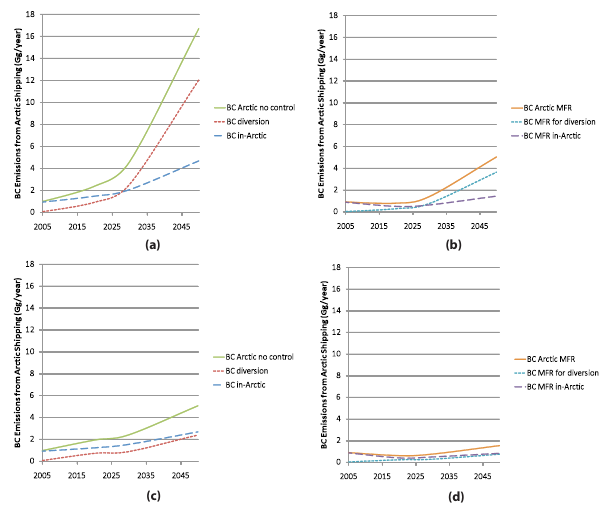
Fig. 4. Comparison of in-Arctic and potential diversion trends for black carbon through 2050 with the following scenarios: (a) high growth – no control, (b) and high growth – MFR control, (c) BAU – no control and (d) BAU – MFR